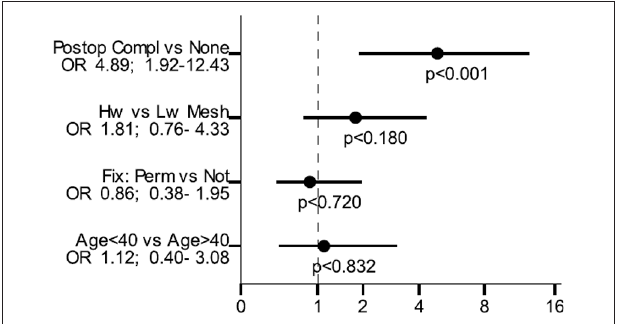
FigUre 5 | Risk factor analysis for sexual dysfunction related to